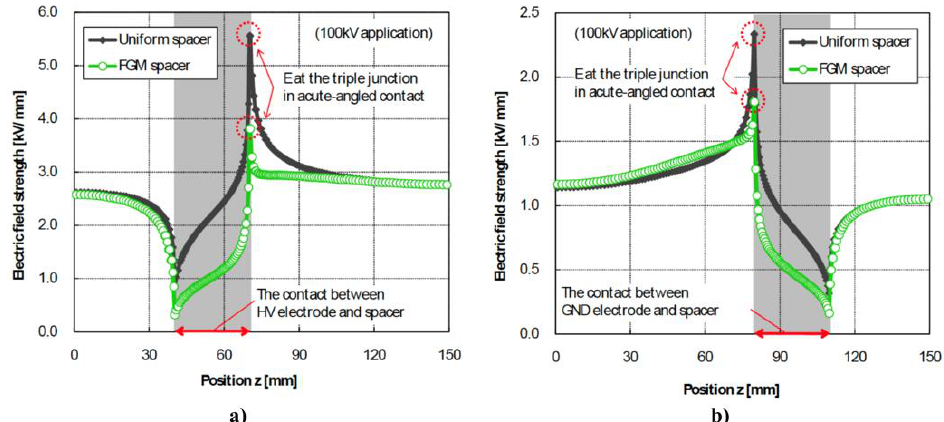
Figure 57. Electric field distribution on HV and GND electrode surfaces. Electric field strength on ( a ) HV electrode surface and ( b ) GND electrode surface. © 2021 IEEE. Reprinted, with permission, from [121].